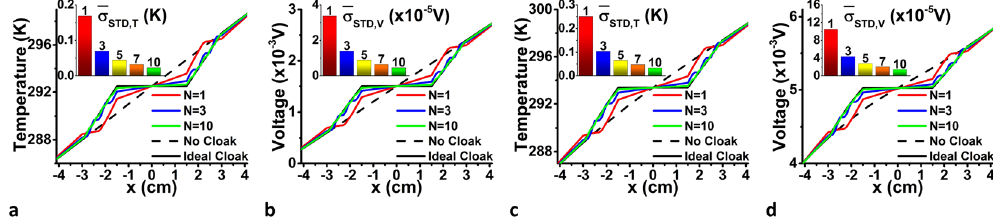
Figure 4. Quantification of the cloaks’ efficacies. Characteristic profiles as a function of horizontal position x for a horizontal line through the center of the entire medium is shown for simulations for ( a ) temperature, ( b ) voltage under TE boundary conditions, and ( c ) temperature, ( d ) voltage under transverse boundary conditions for a medium with no cloak, an ideal cloak, and laminate cloaks with N = 1, 3, and 10 bilayers. The corresponding standard deviations between a medium with laminate cloaks with N = 1, 3, 5, 7, and 10 bilayers and a medium with no cloak, calculated on a grid with M = 100 × 100 points, are shown as inserts in each